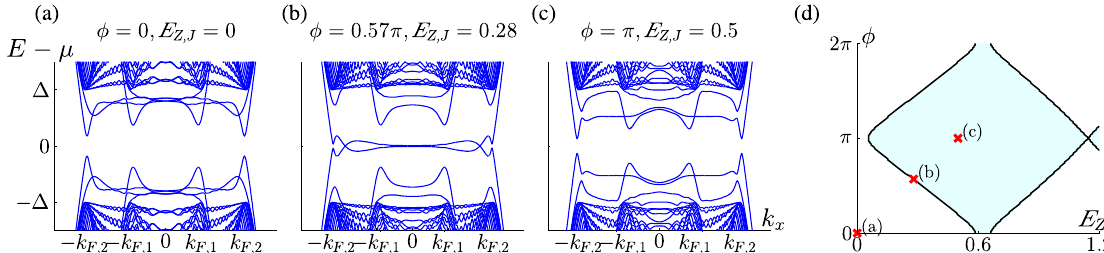
FIG. 7. (a – c) Energy spectrum across the topological phase transition calculated using a tight-binding model for the system (see Appendix D 2 for details). The tight-binding parameters used are W ¼ 5 , W momenta k are calculated in the absence of a Zeeman field. The values of ϕ and E F; 1 = 2 by crosses on the phase diagram shown in (d). The phase diagram is obtained by calculating the topological invariant for class D, τ τ Q ¼ sign ½ Pf ð H = Pf ð H [32]. In (a), the system is in the trivial phase; in (b), the gap at k k ¼ π x Þ k ¼ 0 x Þ(cid:4) undergoes a topological phase transition; and in (c), the system is in the topological